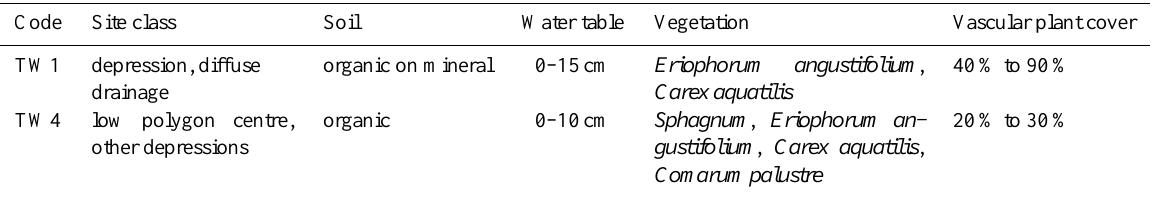
Table 1. Description of the studied vegetation classes. Code Water table Vegetation Vascular plant